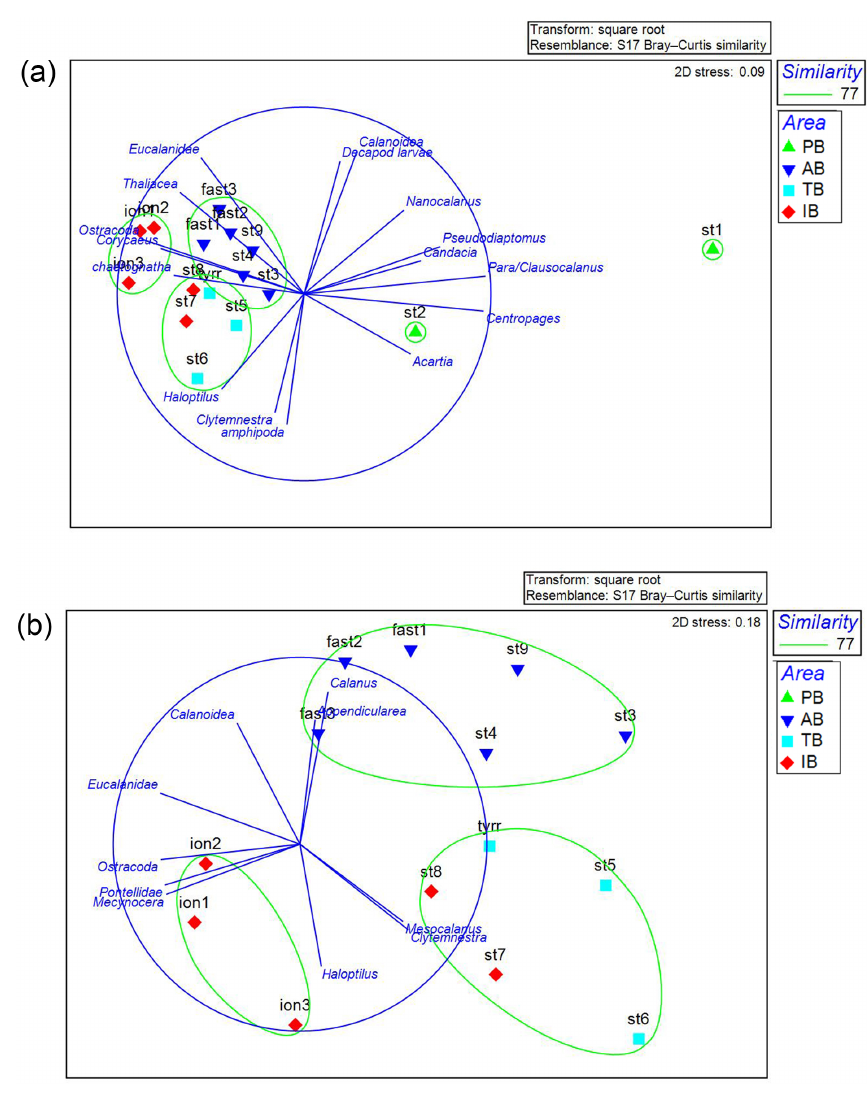
Figure 8. NMDS analysis of the zooplankton taxa for all stations (a) excluding ST 1 and ST2. (b) A plot of the stations and the taxa correlated at > 0 . 65 with the axes. The color of the stations represents the areas identified by the PCA in the environmental analysis (see Fig. 2). This analysis was performed on the zooplankton collected with the data from N 200 . PB refers to Provencal Basin, AB refers to Algerian Basin, TB refers to Tyrrhenian Basin, and IB refers to Ionian